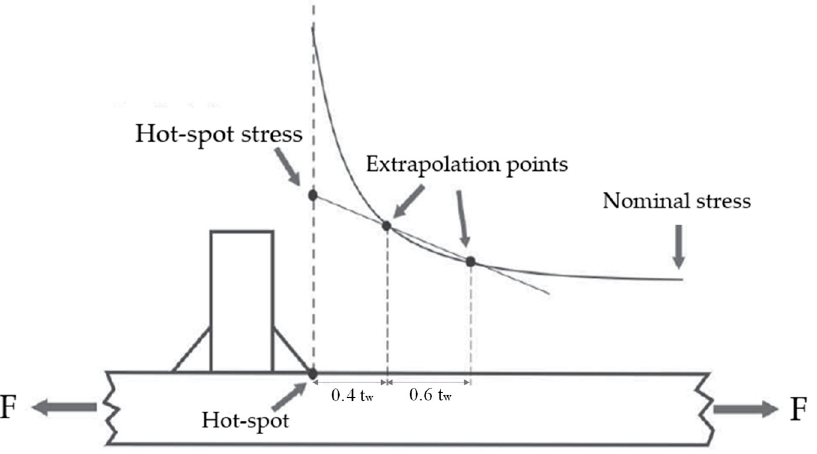
Figure 2. Extrapolation method. Adapted from: IIW [41] (adapted by the author [42]). It is important to mention that for the different types of joints, the same S-N curve is simply considered, formed by the amplitude of stresses on the vertical axis and the number of cycles on the horizontal axis. The fatigue life for 2 × 10 6 cycles is described by Equation (1), where ∆ σ hs is the variation of the hot-spot stress amplitude (in MPa), N is the number of cycles to failure, m is the slope of the curve S–N, and C is the design value of the fatigue strength of the joint.